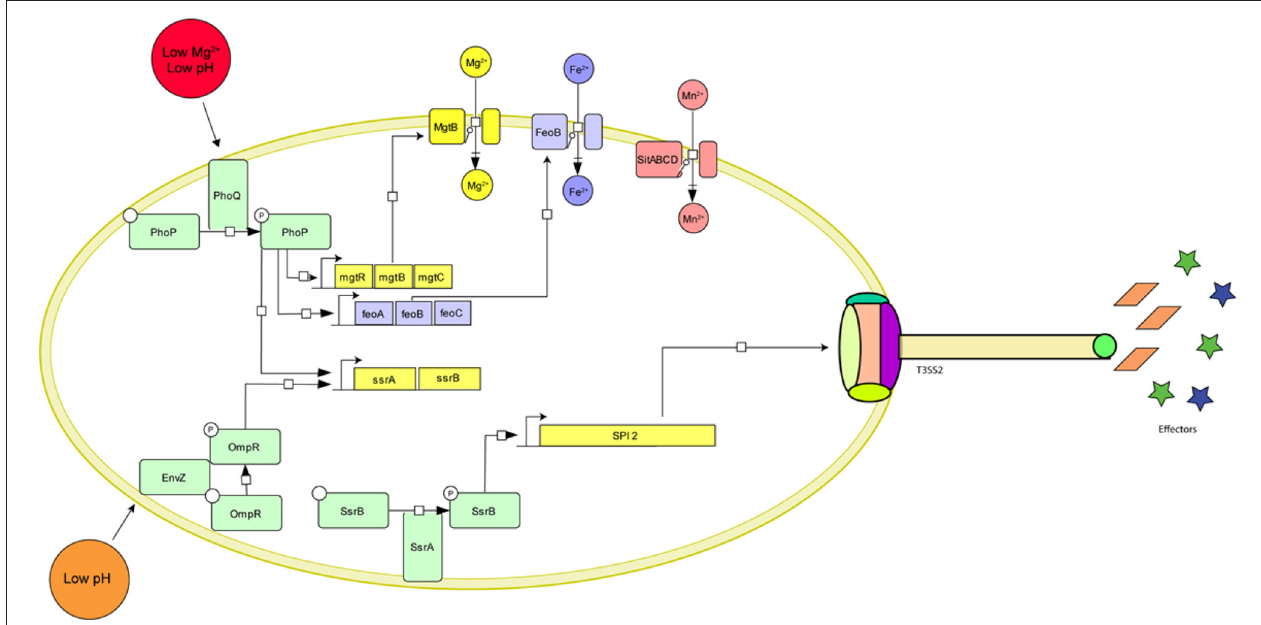
FIGURE 1 | Graphical representation of the major Salmonella genes required for survival inside macrophages and their environmental cues. The two master regulators, PhoPQ and OmpR-EnvZ sense the low pH and Mg 2 + concentration inside the SCV and initiate a cascade of gene activation resulting in the upregulation of ion importers (MgtRBC, FeoABC, and SitABCD), SPI activation (SPI2, SPI13), formation of the Type III secretion system needle complex and expression of effector